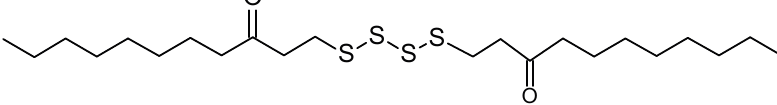
Figure 3. Bis-(3-oxoundecyl) tetrasulfide (possible hit of Peak 13 or ii from Dictionary of Marine Natural